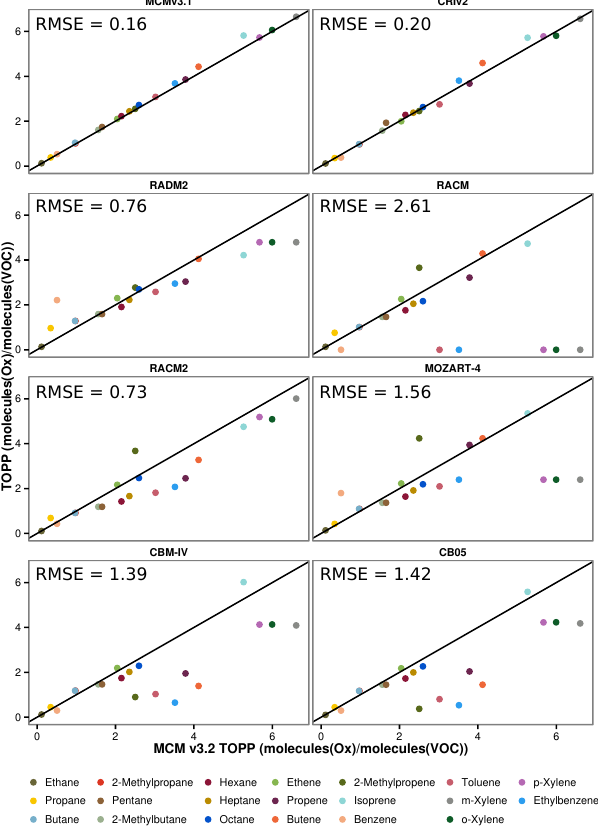
Figure 4. The first-day TOPP values for each VOC calculated using MCM v3.2 and the corresponding values in each mechanism. The root mean square error (RMSE) of each set of TOPP values is also displayed. The black line is the 1 : 1